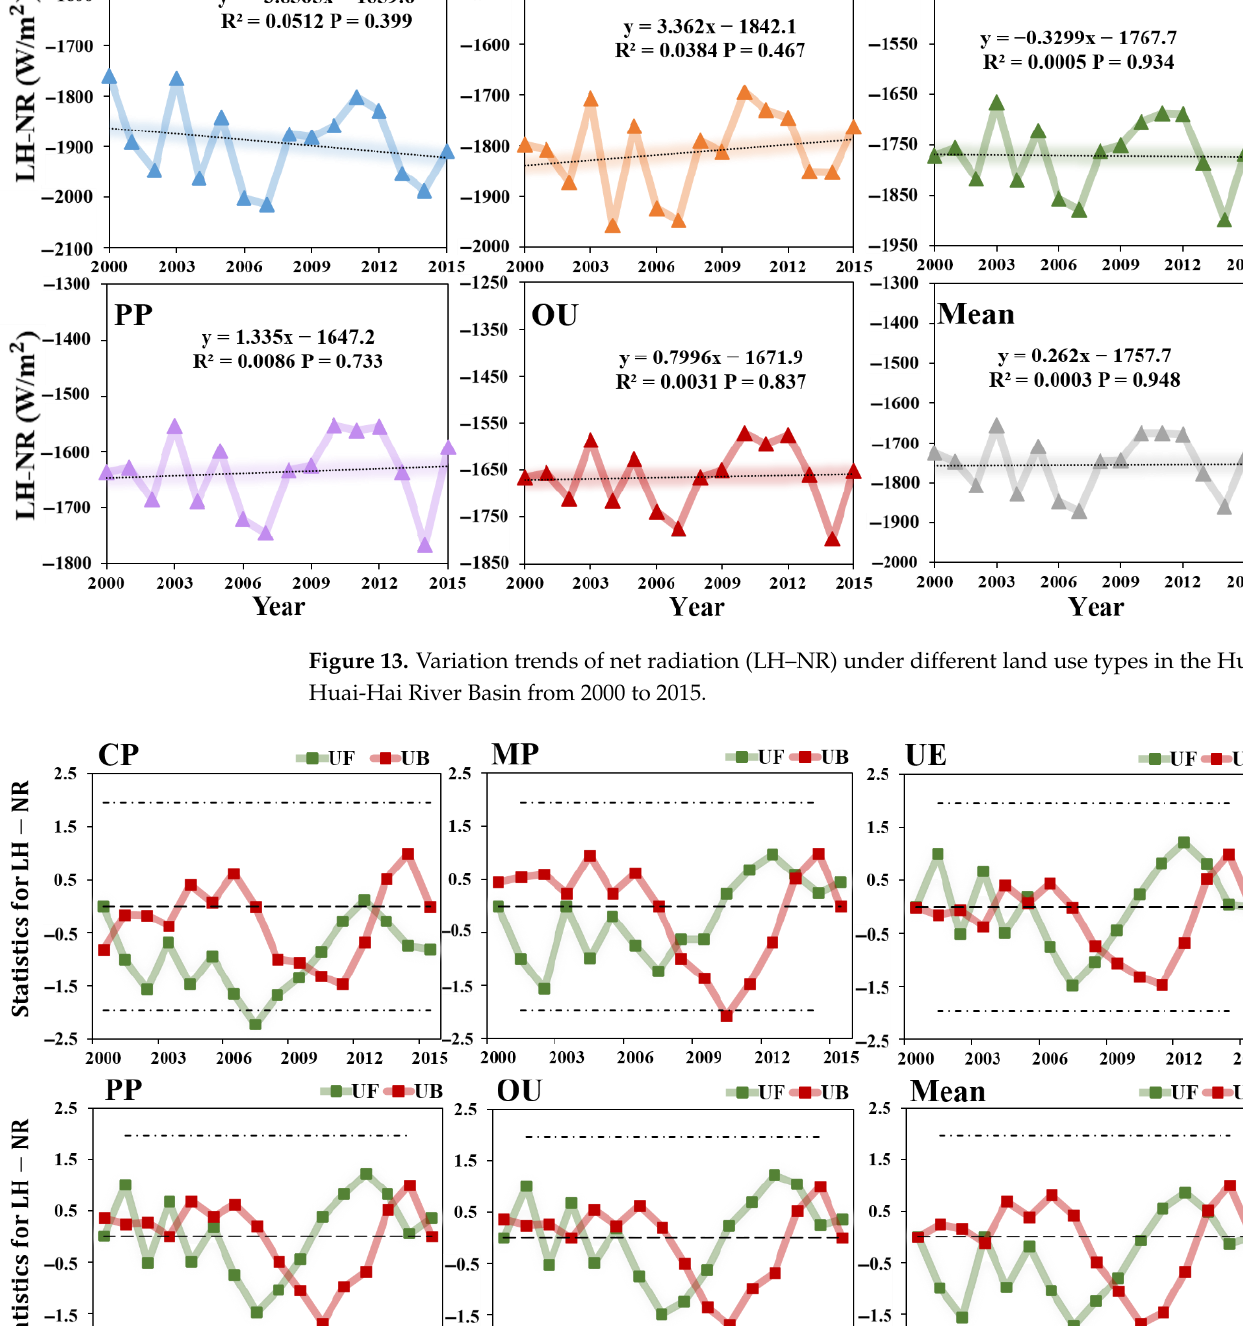
Figure 12. ( a ) Spatial variation ( LH − NR ) and ( b ) statistical values for the five land use types in the Huang-Huai-Hai River Basin from 2000 to 2015.